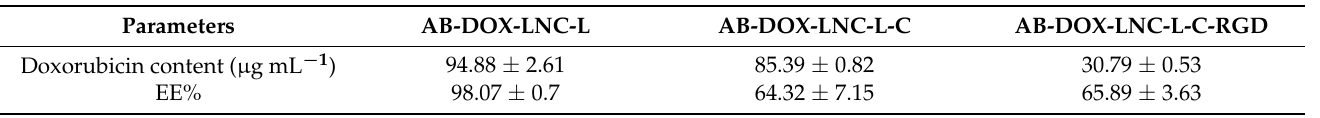
Table 2. Doxorubicin content determined by liquid chromatography and encapsulation efficiency of doxorubicin (EE%) determined by ultrafiltration-centrifugation following